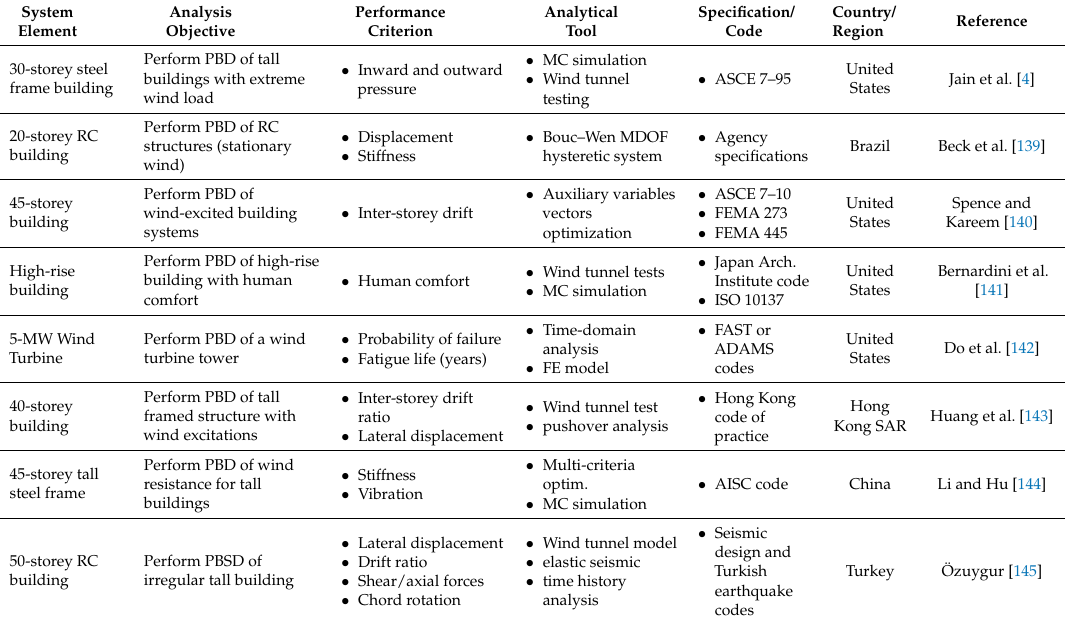
Table A10. Characteristics of building wind-based design